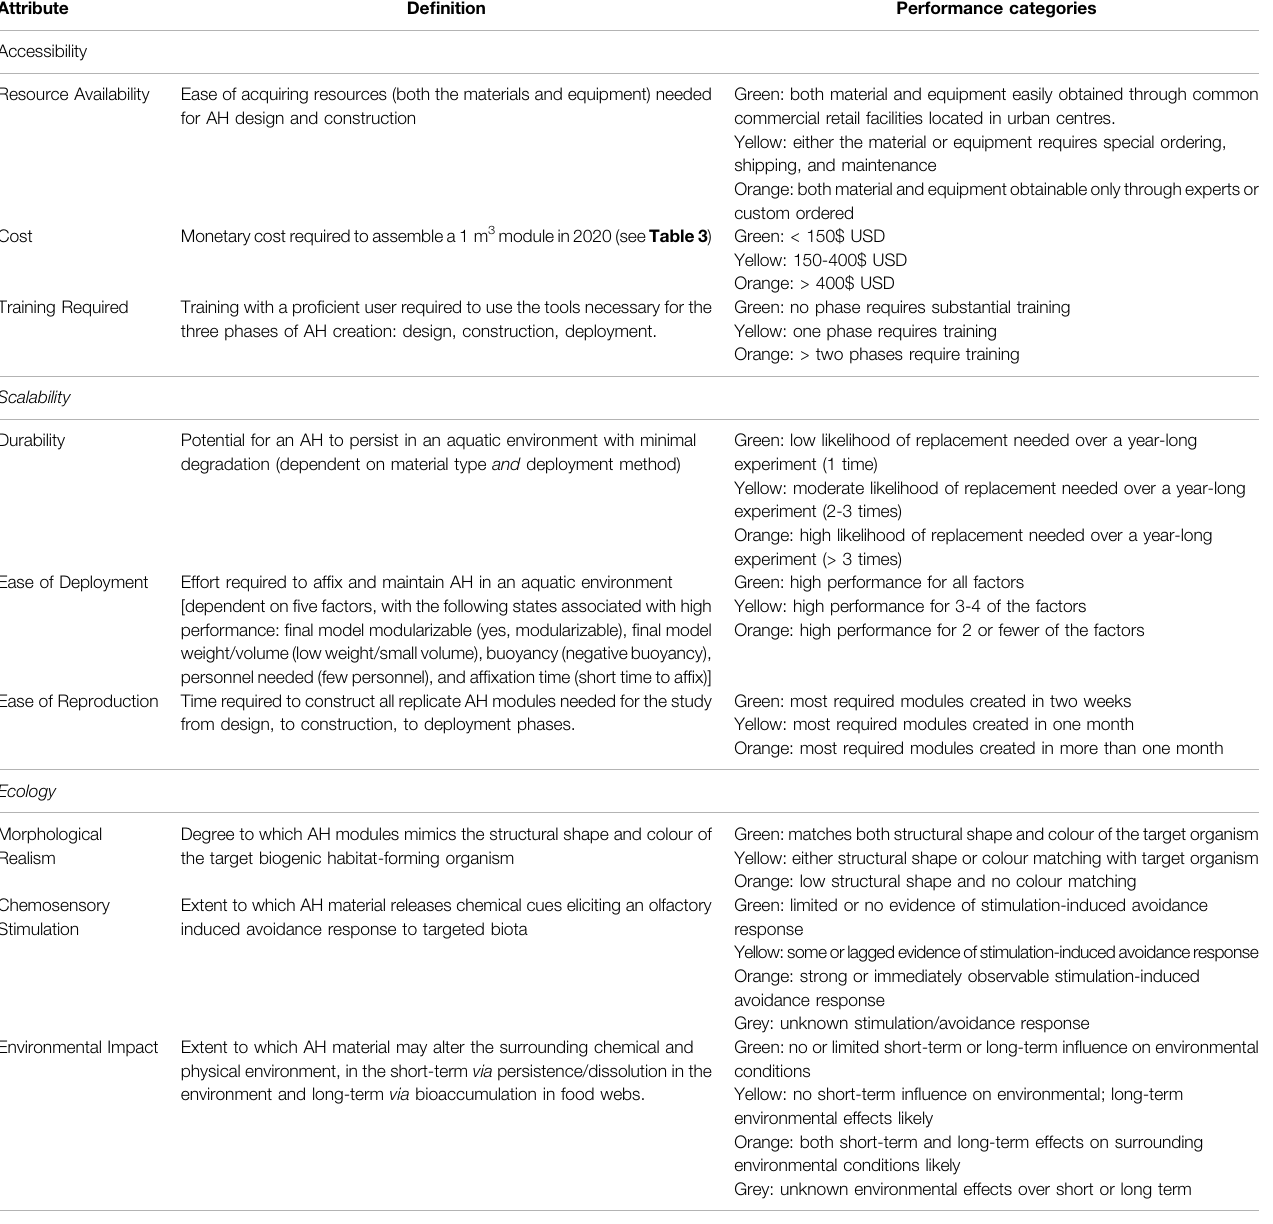
TABLE 1 | Descriptions for key attributes affecting the performance of Arti fi cial Habitat (AH) module designs for aquatic research, and associated criteria for high (green), moderate (yellow), low (orange), and unknown response (grey) performance for components of each attribute.